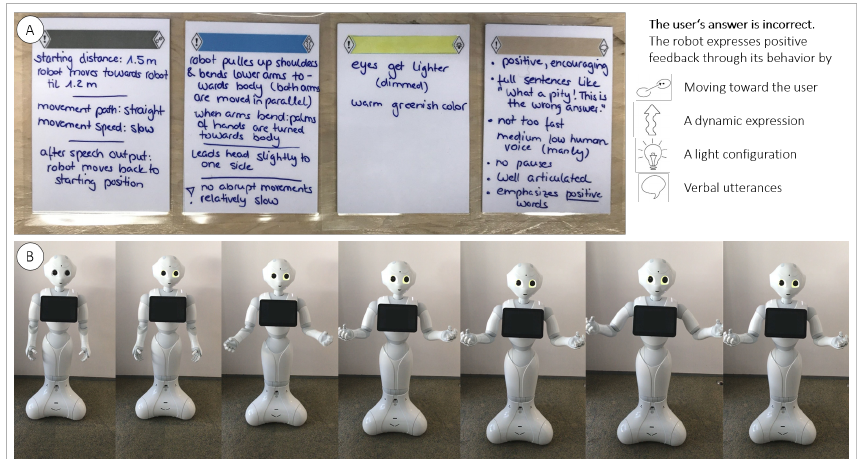
Figure 7. Example for a behavioral expression for the negative feedback situation: ( A ) Idea cards documenting the design solution. ( B ) Implementation on the Pepper